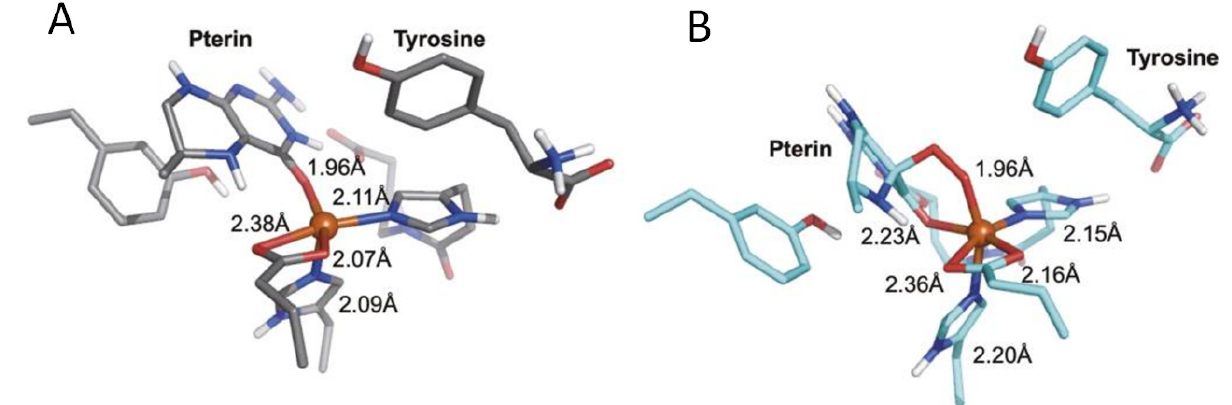
Figure 9. Structures of the human tryptophan-hydroxylase ternary complex ( A ) and the peroxy intermediate with the pterin carbonyl bound ( B ). The metal–ligand distances are indicated. © 2022 National Academy of Sciences of the United States of America.